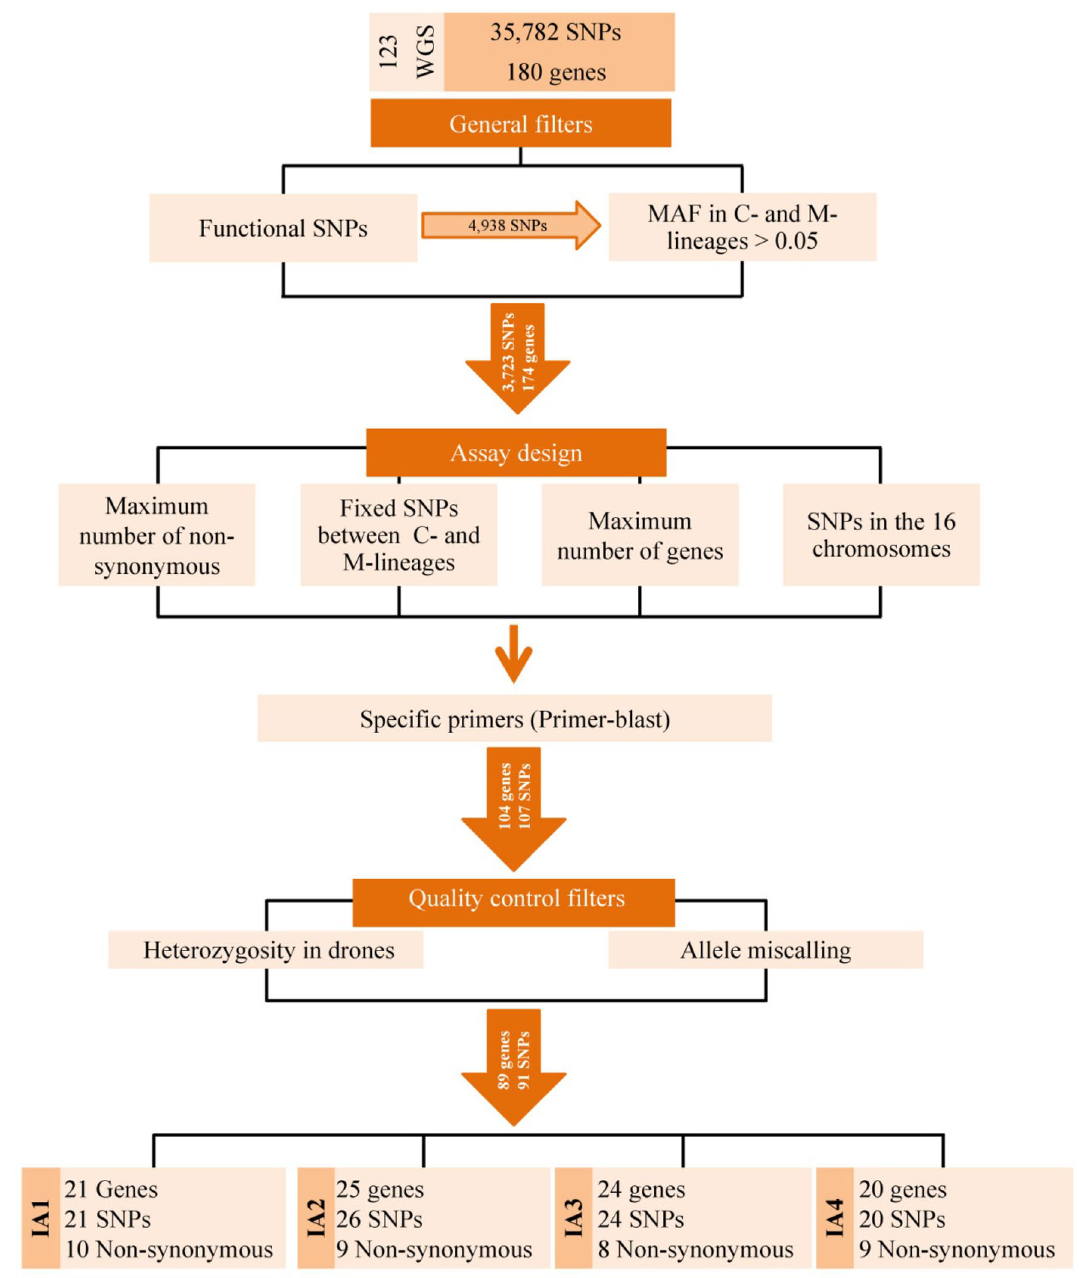
Figure 2. Diagram depicting the different criteria and steps involved in the development of the four SNP assays (IA1, IA2, IA3, and IA4) using as a baseline whole ‐ genome sequence data from 123 individuals representing seven honey bee